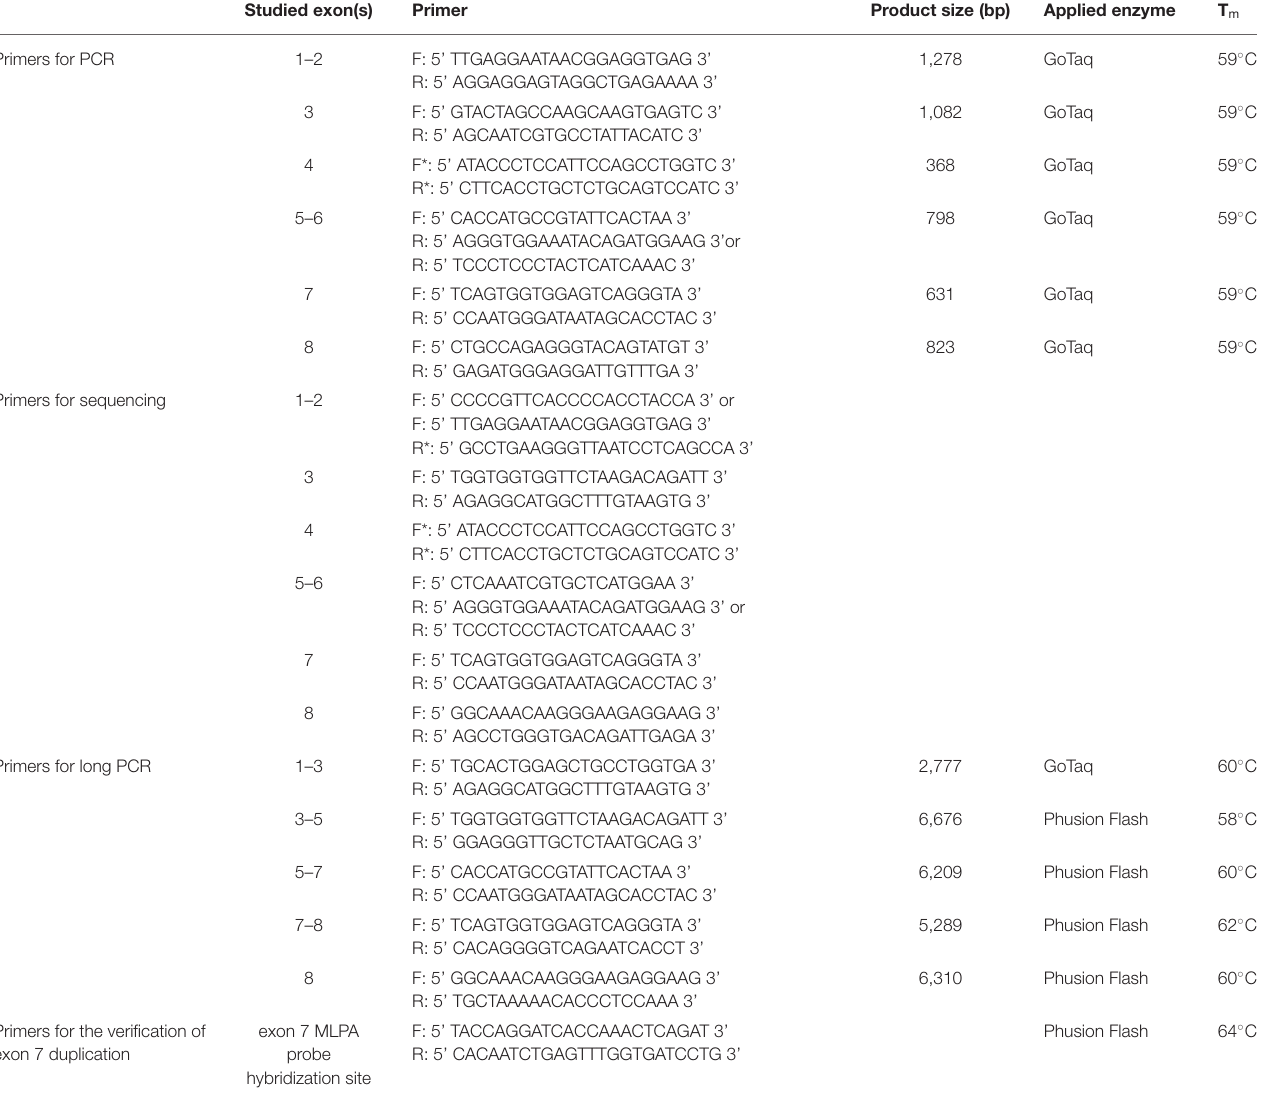
TABLE 1 | Primer sequences and PCR conditions applied in this study. Studied exon(s) Primer Product size (bp) Applied enzyme T m Primers for